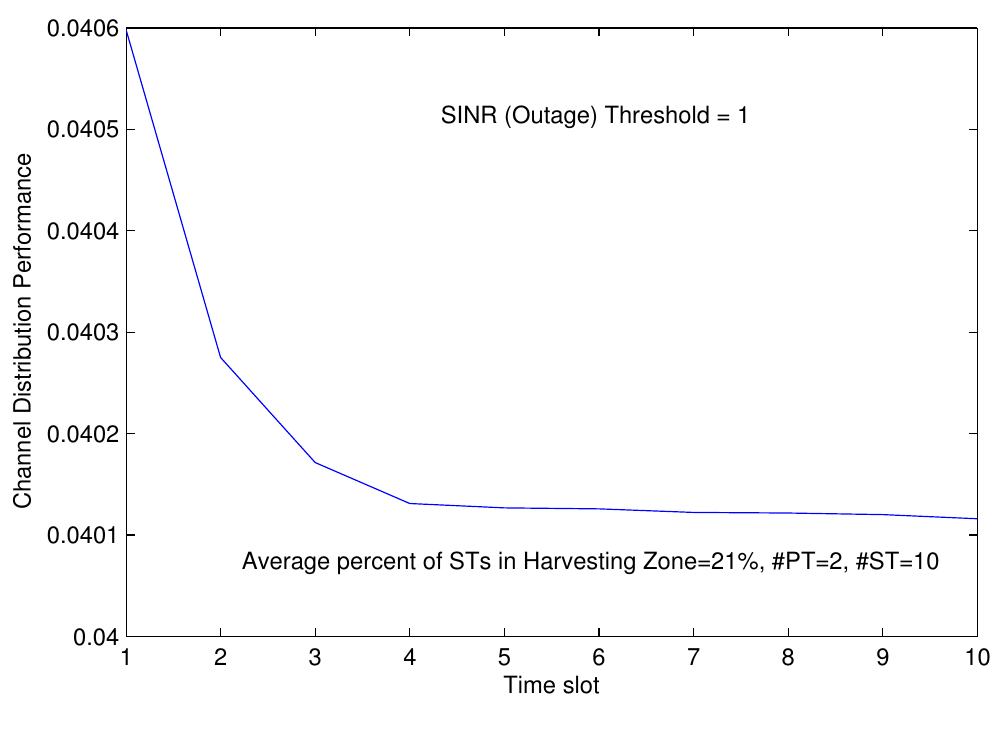
Figure 10. ChDistFairness against time slots for constant percentage of STs in the harvesting zone of 21% and constant SINR (Outage) threshold of 1.